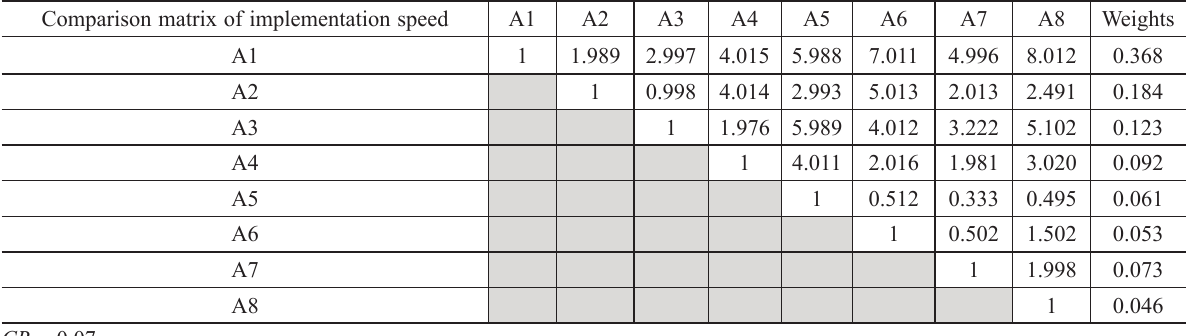
Table 11. Importance degree of any laminated glass models related to implementation speed Comparison matrix of implementation speed